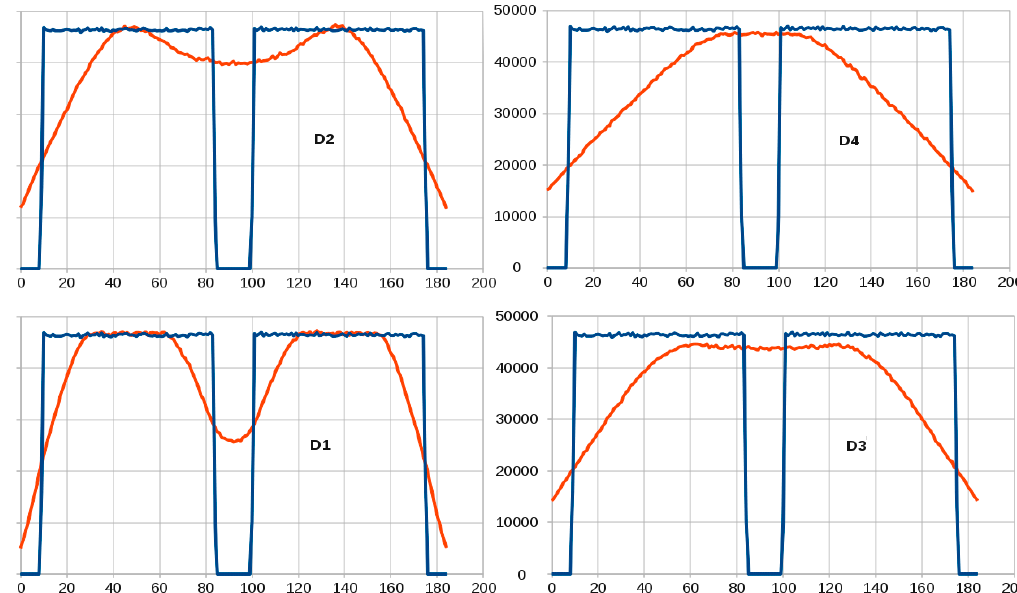
Figure 18. Computer simulations showing radiation profiles collected at detectors D1, D2 (before P1 hole), D3 and D4 (after P1 hole). Blue indicates parallel rays, red indicates non-parallel, calibrated rays. Calibrated rays were generated multiplying a scaling factor, as explained in Section 5.3. The vertical axis represents the simulated radiation flux (resulting from 10 9 input rays). The horizontal axis represents the horizontal radial distance (with the central hole in the middle).